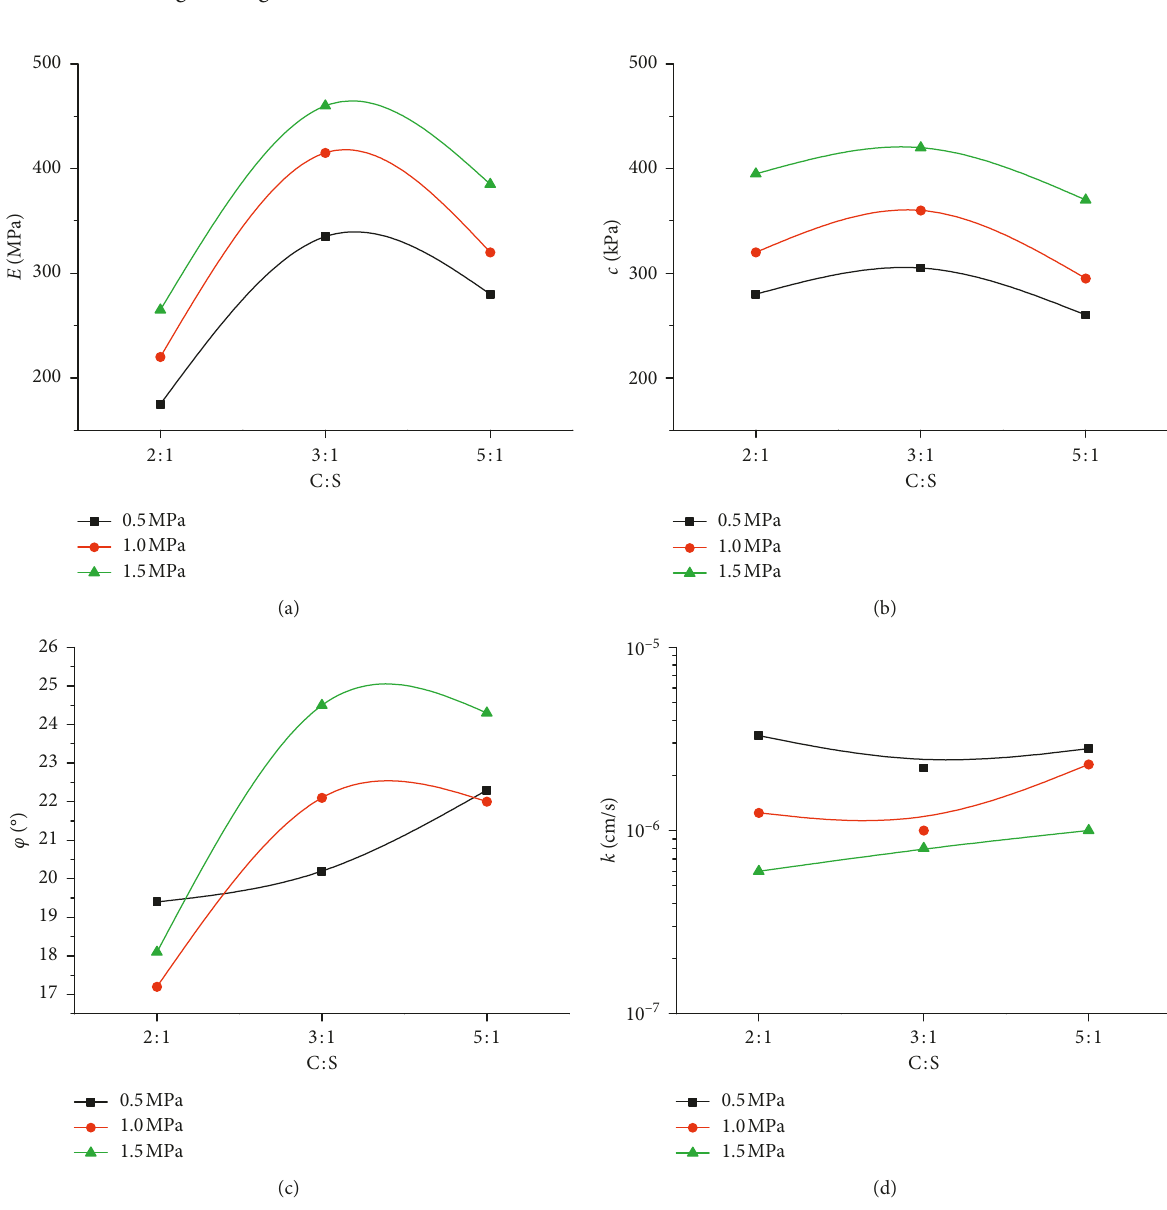
Figure 3: Relationship between mechanical properties of grouting and solid and the ratio of